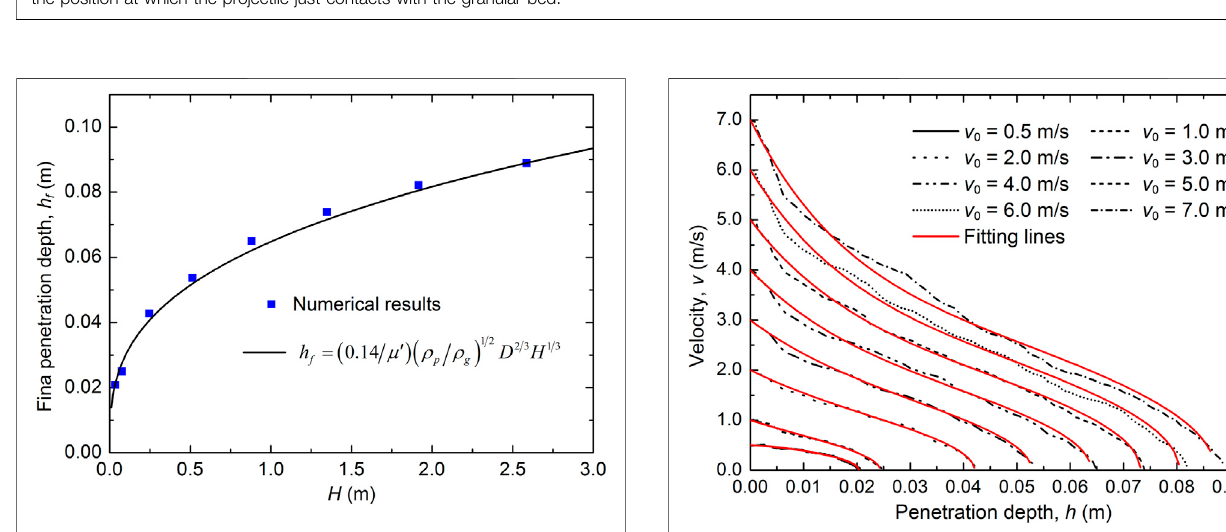
FIGURE 5 | Evolutions of the (A) velocity ( v ) and (B) penetration depth ( h ) of projectiles for the numerical tests with different impact velocities. y = 0 corresponds to the position at which the projectile just contacts with the granular bed.